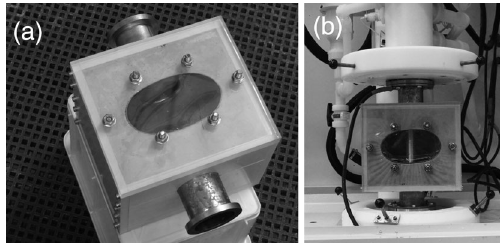
FIG. 10. (a) Mock-up for the viewing of the inside of a single- cell cavity during VEP and (b) setup ready for